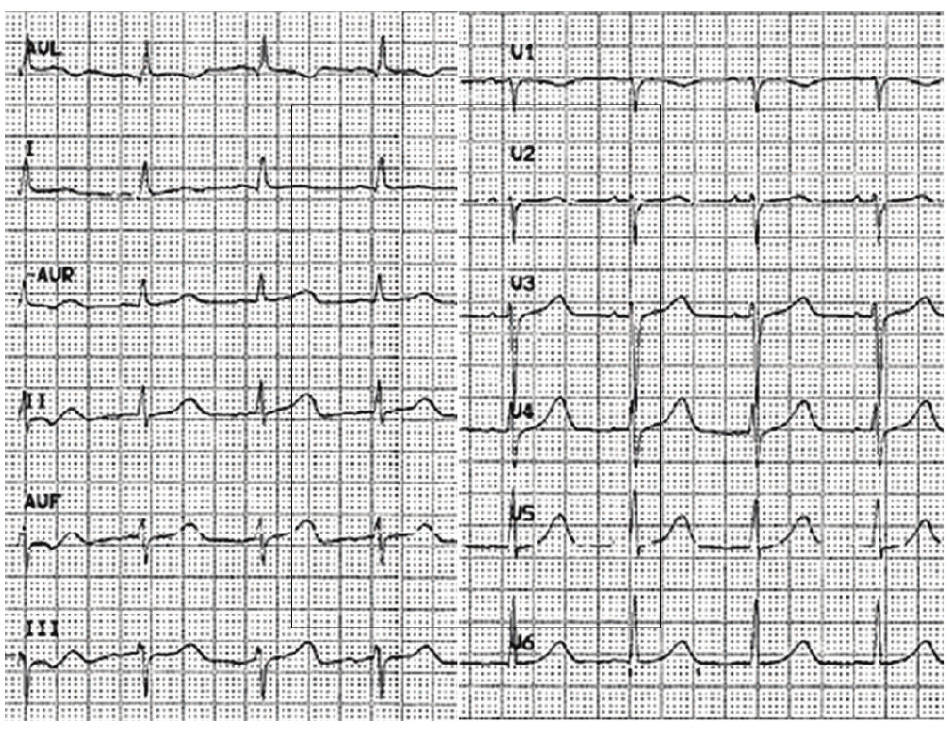
Figure 1: Admission